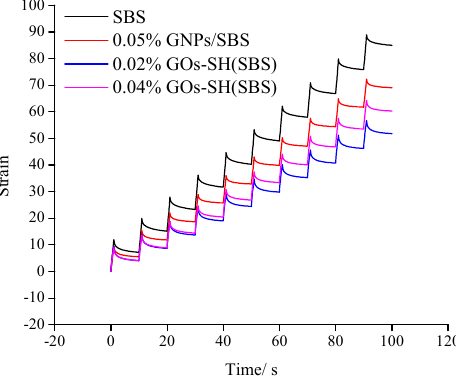
Figure 8. Time-strain relation of different asphalt samples at 0.1 KPa.